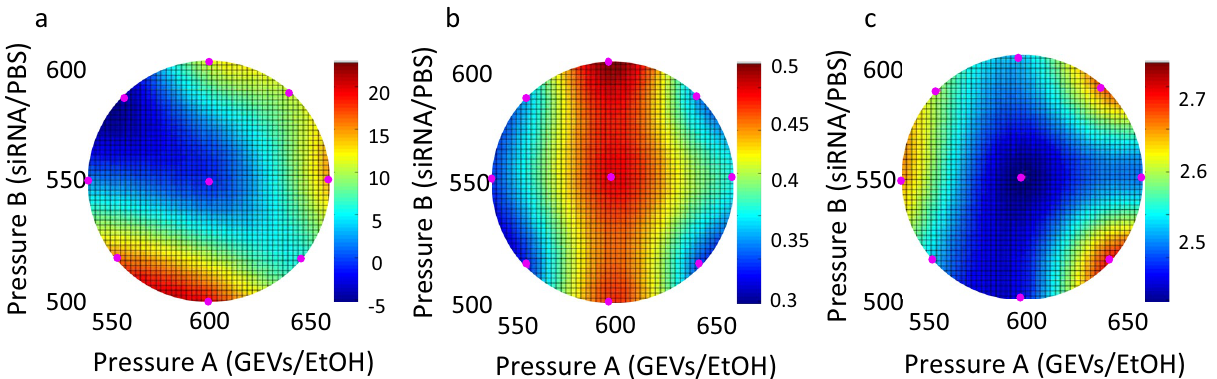
Figure 3. Effect of pressure on particle size, PdI, and loading efficiency of siRNA-GEVs prepared using a microfluidic method. The response surface method was applied to analyze data obtained using the design of experiment (DoE) approach. Response surface models of ( a ) mean particle size, ( b ) loading efficiency, and ( c ) PdI are shown. Pressures A and B are fluid pressures in the siRNA/PBS and GEVs/EtOH channels,